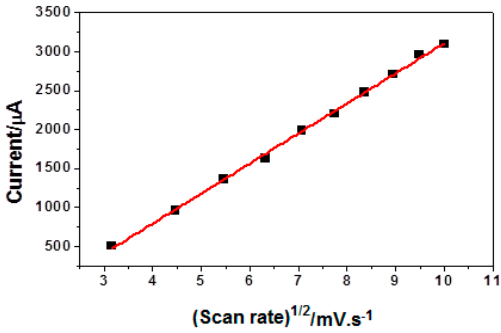
Figure 6. Randles–Sev č ik plot for the cathodic Peak c ′ of Figure 4.